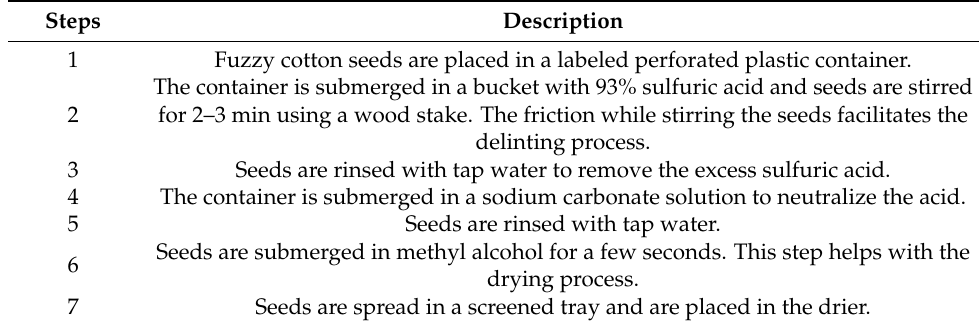
Table 1. Delinting process steps at Texas A&M AgriLife Research Cotton Breeding Program in Lubbock,